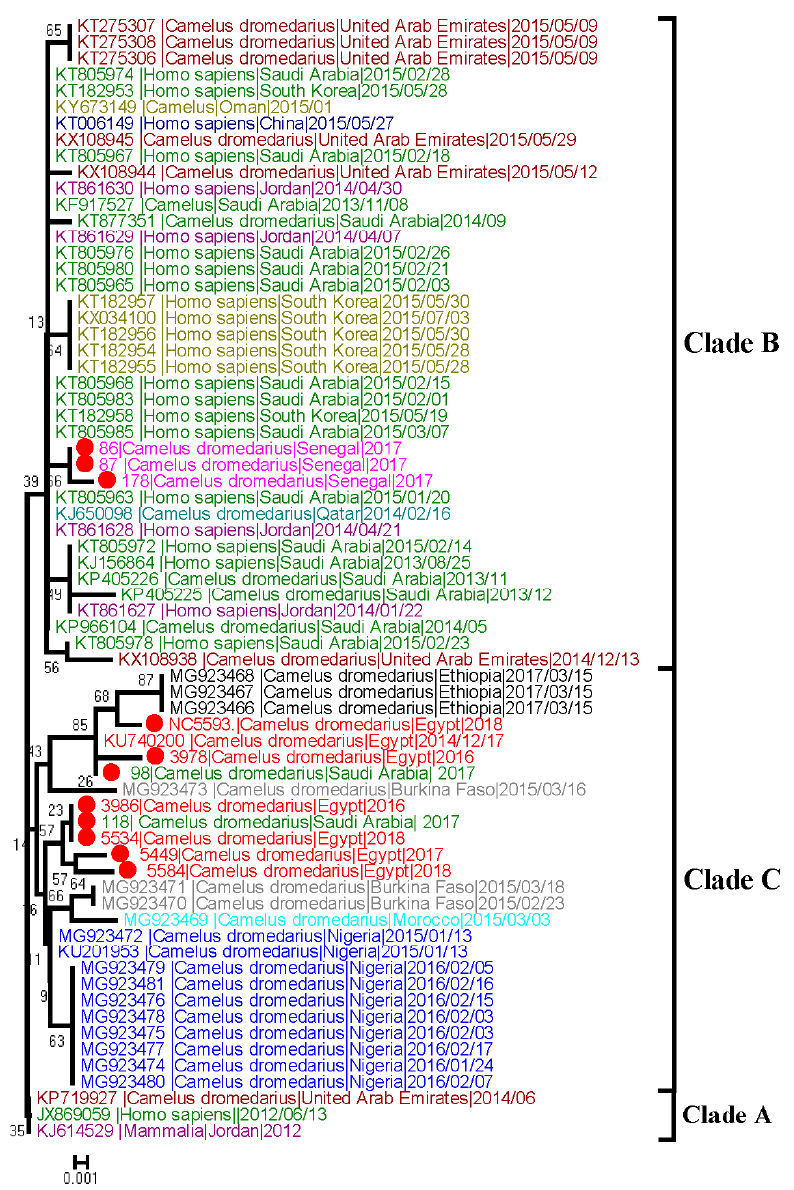
Figure 3. Phylogenetic tree of the partial Spike gene of RBD of MERS-CoV (=701bp). Tree was generated using MEGA6 with bootstrap method and Kimura 2-parameter model. Sequences obtained in this study are labelled with a red circle, other MERS-CoV sequences from different countries are categorized by colors.